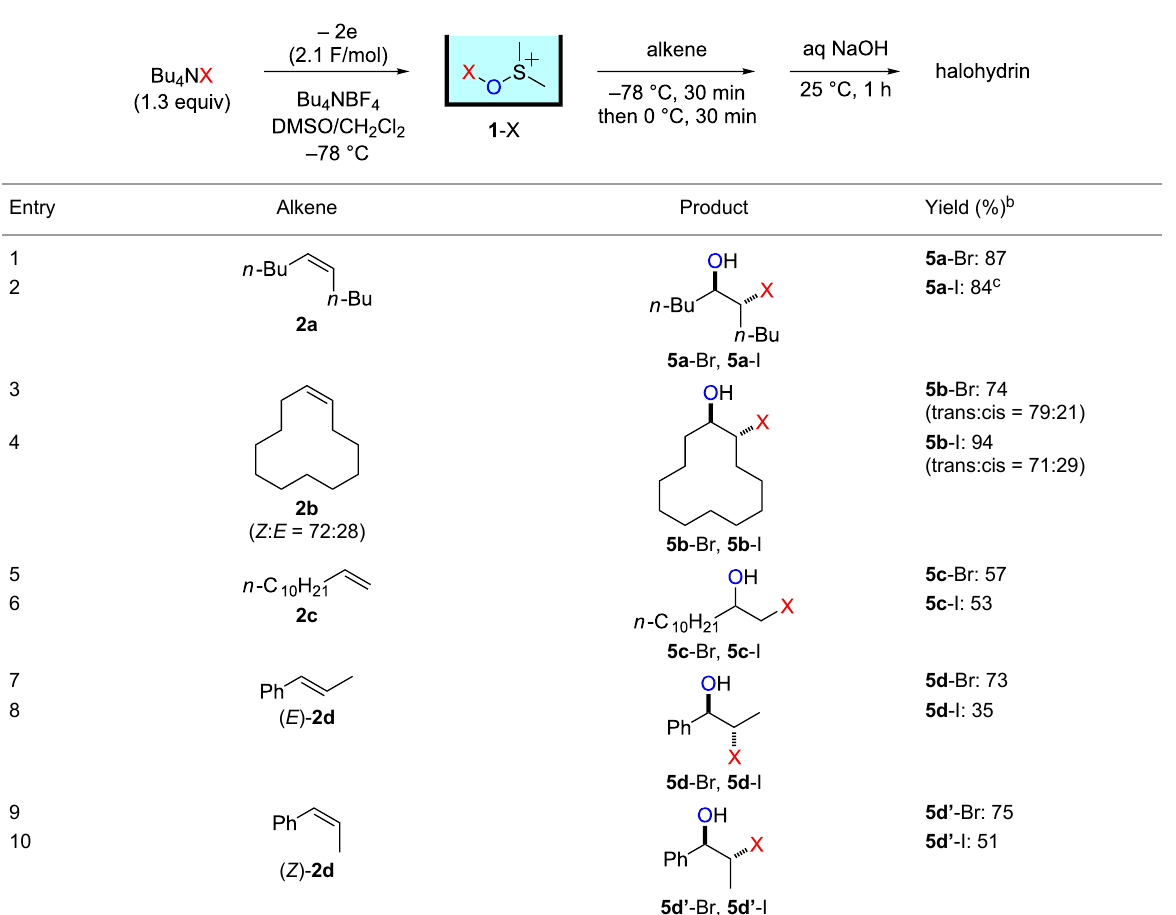
Table 2: Synthesis of halohydrins by the reaction of 1 -X with alkenes followed by the treatment with NaOH. a